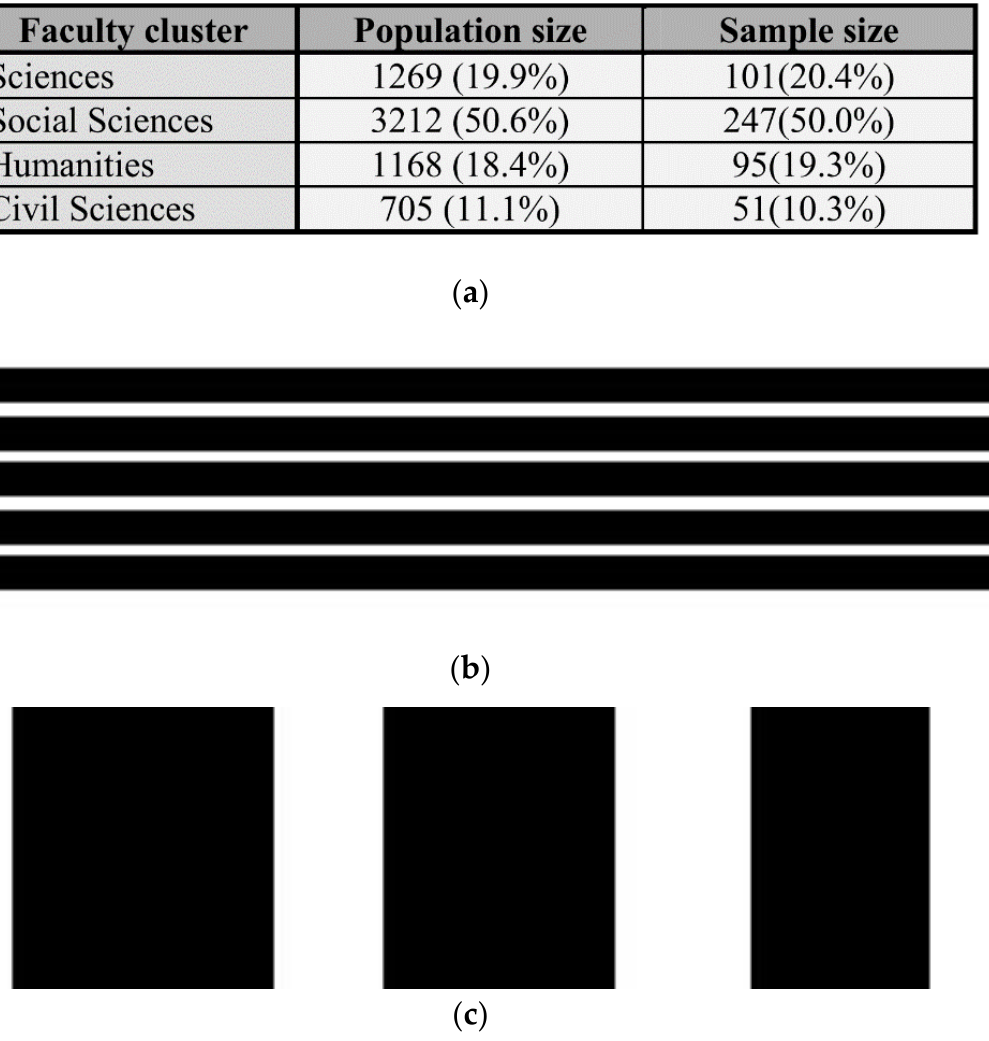
Figure 8. ICDAR2013 tabular dataset ( a ) table image; ( b ) line segmentation mask map; ( c ) column segmentation mask map.